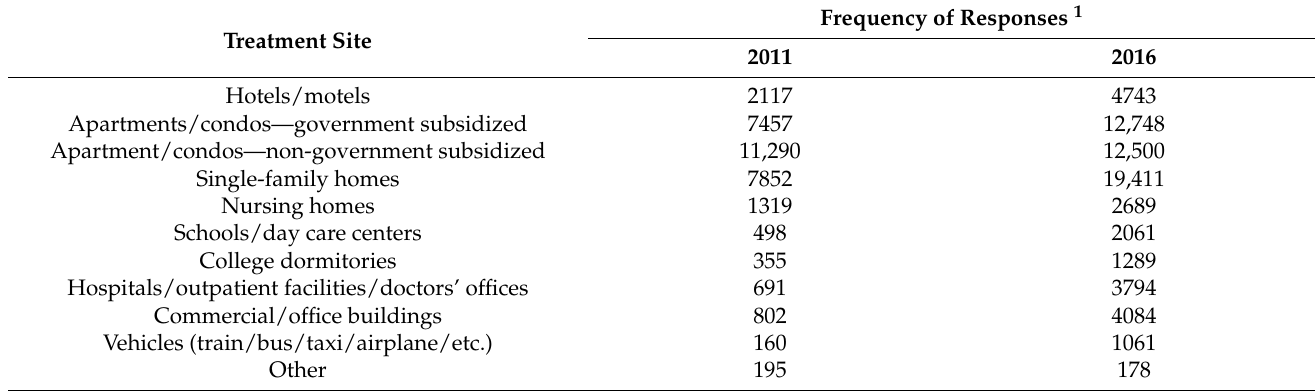
Table 1. Sites treated by licensed PMPs in 2011 and